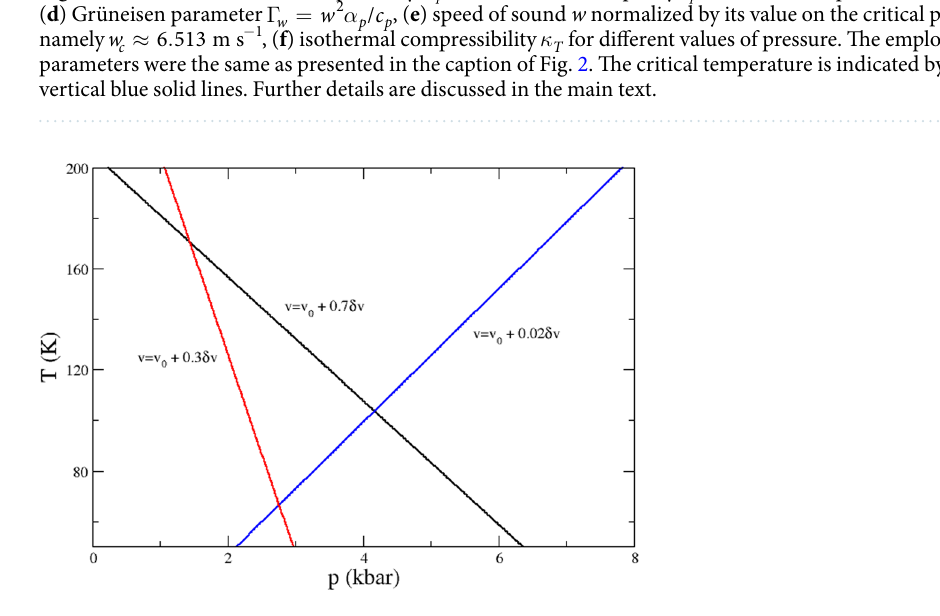
Figure 4. Temperature ( T ) versus pressure ( p ) phase diagram for three different values of volume ( v ), as indicated in the label. A linear relation is observed between T and p for all values of v . For values close to the upper limit of the volume, the pressure reaches negative values and the angular coefficient of the mathematical relation between T and p changes sign. For high values of v (more precisely, for δ > + . v v v 0 17 where λ = . 0 2 ), the angular coefficient is negative, indicating a decrease in temperature as pressure increases. The values of v 0 and δ v employed here are the same as in Fig.